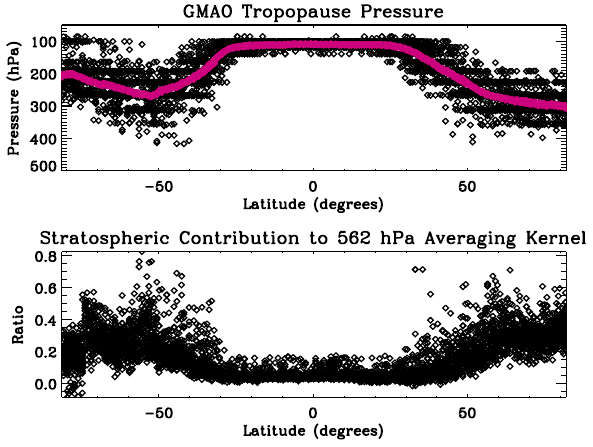
Fig. 5. (Top panel) Tropopause height from GMAO. The red line is the latitudinal average. (Bottom panel) Contribution of stratospheric differences between TES a priori and “true” CH 4 distributions to the TES tropospheric CH 4 estimate at 562hPa.